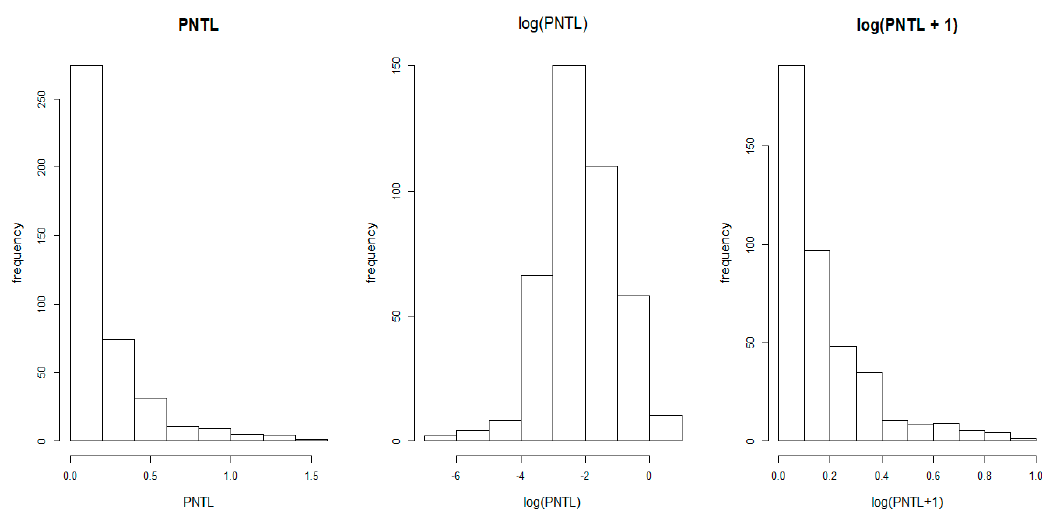
Figure 7. Frequency distributions of the PNTL.